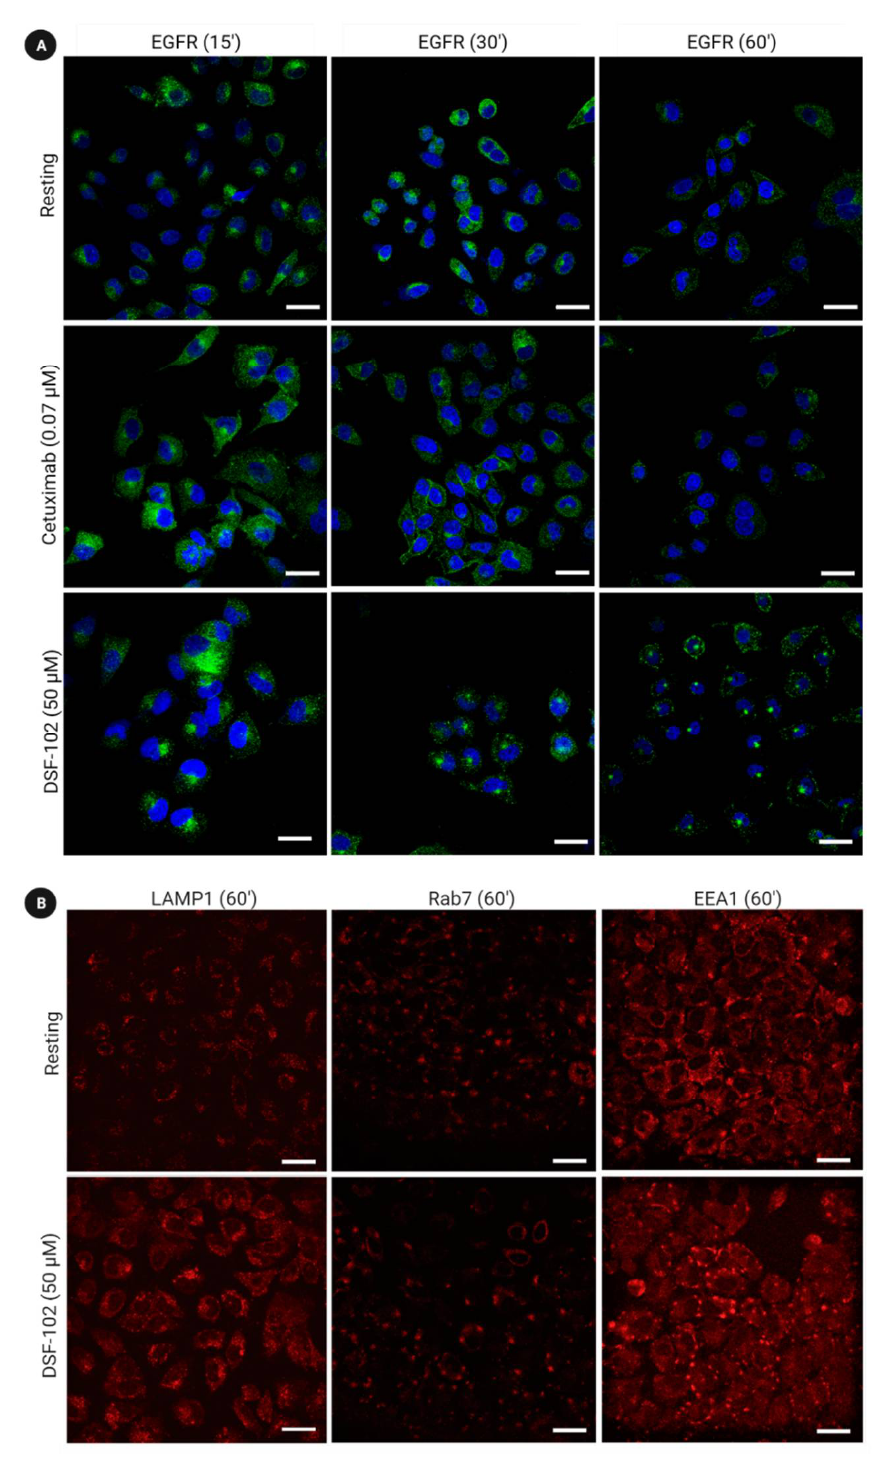
Figure 5. ( A ) Confocal microscopy images showing the trafficking kinetics of membrane EGFR (green) under resting conditions and after treatment (from 15 to 60 min) with DSF-102 (50 µ M) or cetuximab. Cellular nuclei were counterstained with DAPI (blue). Scale bar: 10 µ m. ( B ) Immunofluorescence analysis of EEA1, Rab7 and LAMP1 (red) in fixed and permeabilized cultures compared to resting cells, at 60 min after treatment with DSF-102 (50 µ M). Scale bar: 10 µ m.